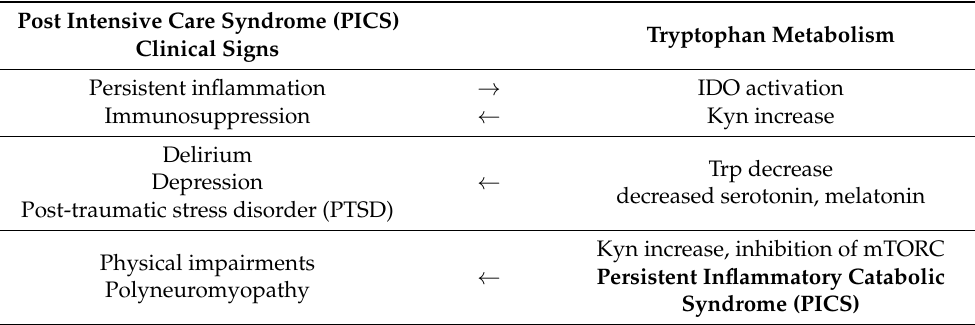
Table 2. Our hypothesis of the effect of tryptophan metabolism on the development of